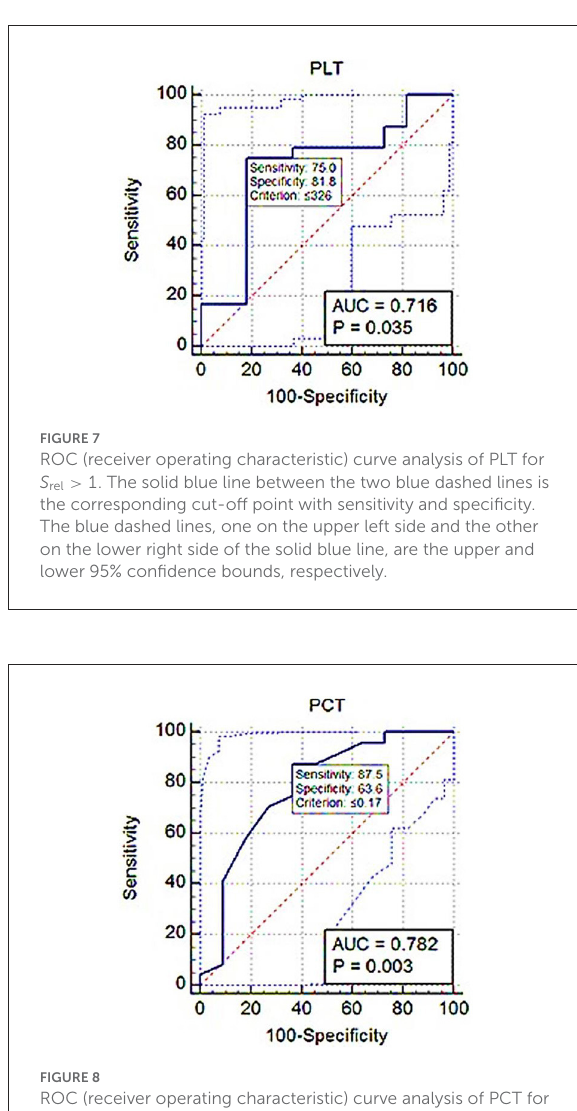
FIGURE8 ROC (receiver operating characteristic) curve analysis of PCT for S rel > 1. The solid blue line between the two blue dashed lines is the corresponding cut-off point with sensitivity and specificity. The blue dashed lines, one on the upper left side and the other on the lower right side of the solid blue line, are the upper and lower 95% confidence bounds,